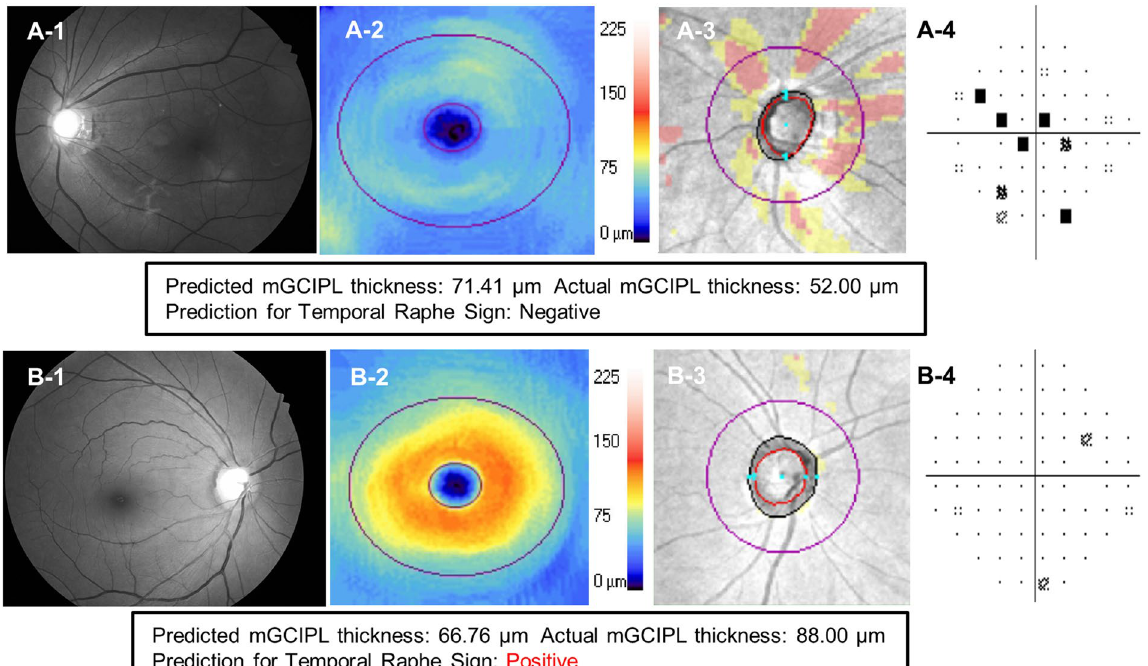
Figure 6. Examples of red-free fundus photographs from which mGCIPL thickness was incorrectly predicted by HDLM. ( A ) Myopic, glaucoma-suspect eye of 39-year-old woman. She had a spherical equivalent refraction of − 10.1 diopters. On the red-free RNFLP (A-1) and RNFL deviation map in SD-OCT (A-3) , superior and inferior RNFL defect is observed. (A-2) Diffuse mGCIPL thinning is also shown on the mGCIPL thickness map. The mGCIPL thickness was predicted to be 71.41 μ m, while the actual thickness measured by SD-OCT was 52.00 μ m. However, the temporal raphe sign was correctly predicted to be negative. ( B ) Healthy eye of 44-year-old woman. There was no structural glaucomatous change on the RNFLP (B-1) or mGCIPL thickness map (B-2) or RNFL deviation map (B-3) . The visual field test also was normal (B-4) . The mGCIPL thickness was predicted to be 66.76 μ m; however, the SD-OCT measured the mGCIPL thickness to 88.00 μ m. Also, the temporal raphe sign was incorrectly predicted to be positive. (HDLM = hybrid deep learning model; RNFL = retinal nerve fiber layer; RNFLP = retinal nerve fiber layer photograph; mGCIPL = macular ganglion cell-inner plexiform layer; SD-OCT = spectral domain-optical coherence